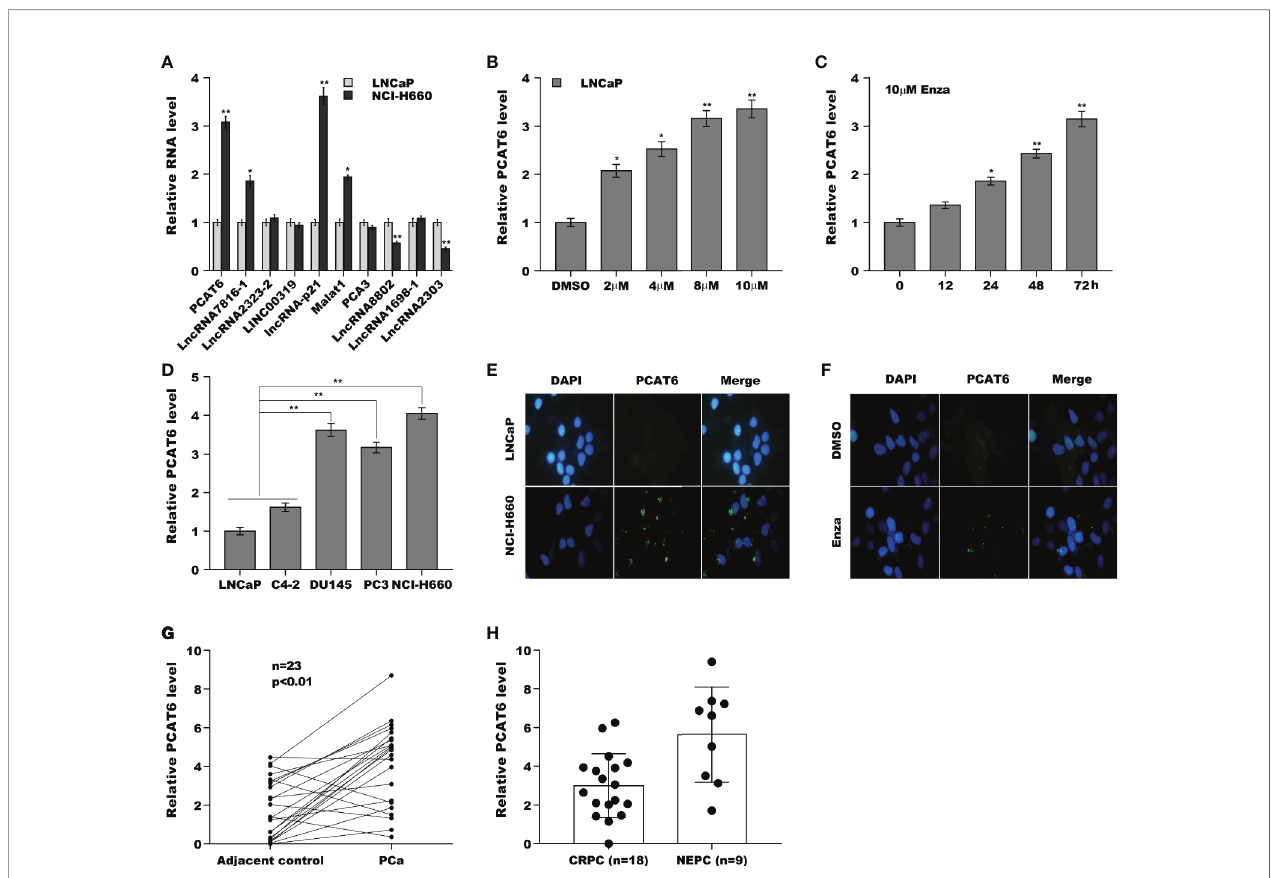
FIGURE 1 | PCAT6 expression was increased in NEPC cells and tissues. (A) qPCR analysis of the top 10 lncRNAs (PCAT6, LncRNA7816-1, LncRNA2323-2, LINC00319, lncRNA-p21, Malat1, PCA3, LncRNA8802, LncRNA1698-1 and LncRNA2303) mRNA expression in NCI-H660 cells and LNCaP cells. (B) qPCR analysis of PCAT6 mRNA expression in NE-like cells (PC3, DU145, and NCI-H660) and LNCaP and C4-2 cells. (C, D) The mRNA expression of PCAT6 was determined in LNCaP cells treated with different Enza concentration (2 m M, 4 m M, 8 m M, 10 m M) for 72 h or 10 m M for different times (0 h, 12 h, 24 h, 48 h, 72 h). (E) Fluorescent in situ hybridization (FISH) assay of the PCAT6 expression in LNCaP and NCI-H660 cells. (F) Fluorescent in situ hybridization (FISH) assay of the PCAT6 expression in LNCaP cells with 10 m M Enza treatment for 72 h. (G) qPCR analysis of PCAT6 expression in Pca tissues and adjacent normal tissues. (H) qPCR analysis of PCAT6 expression in NEPC (n=9) and CRPC (n=18) samples. * p <0.05. ** p